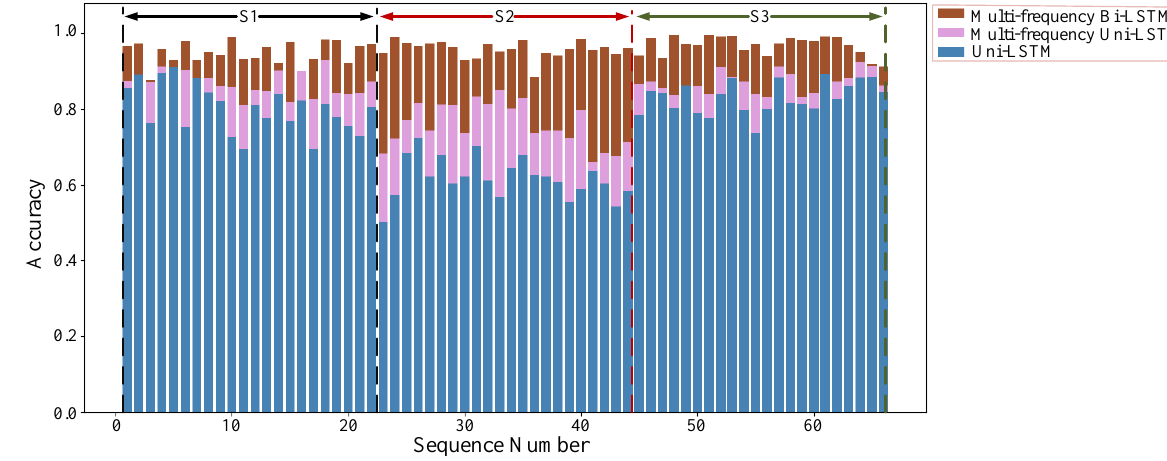
Figure 22. Comparison of recognition accuracy of the three